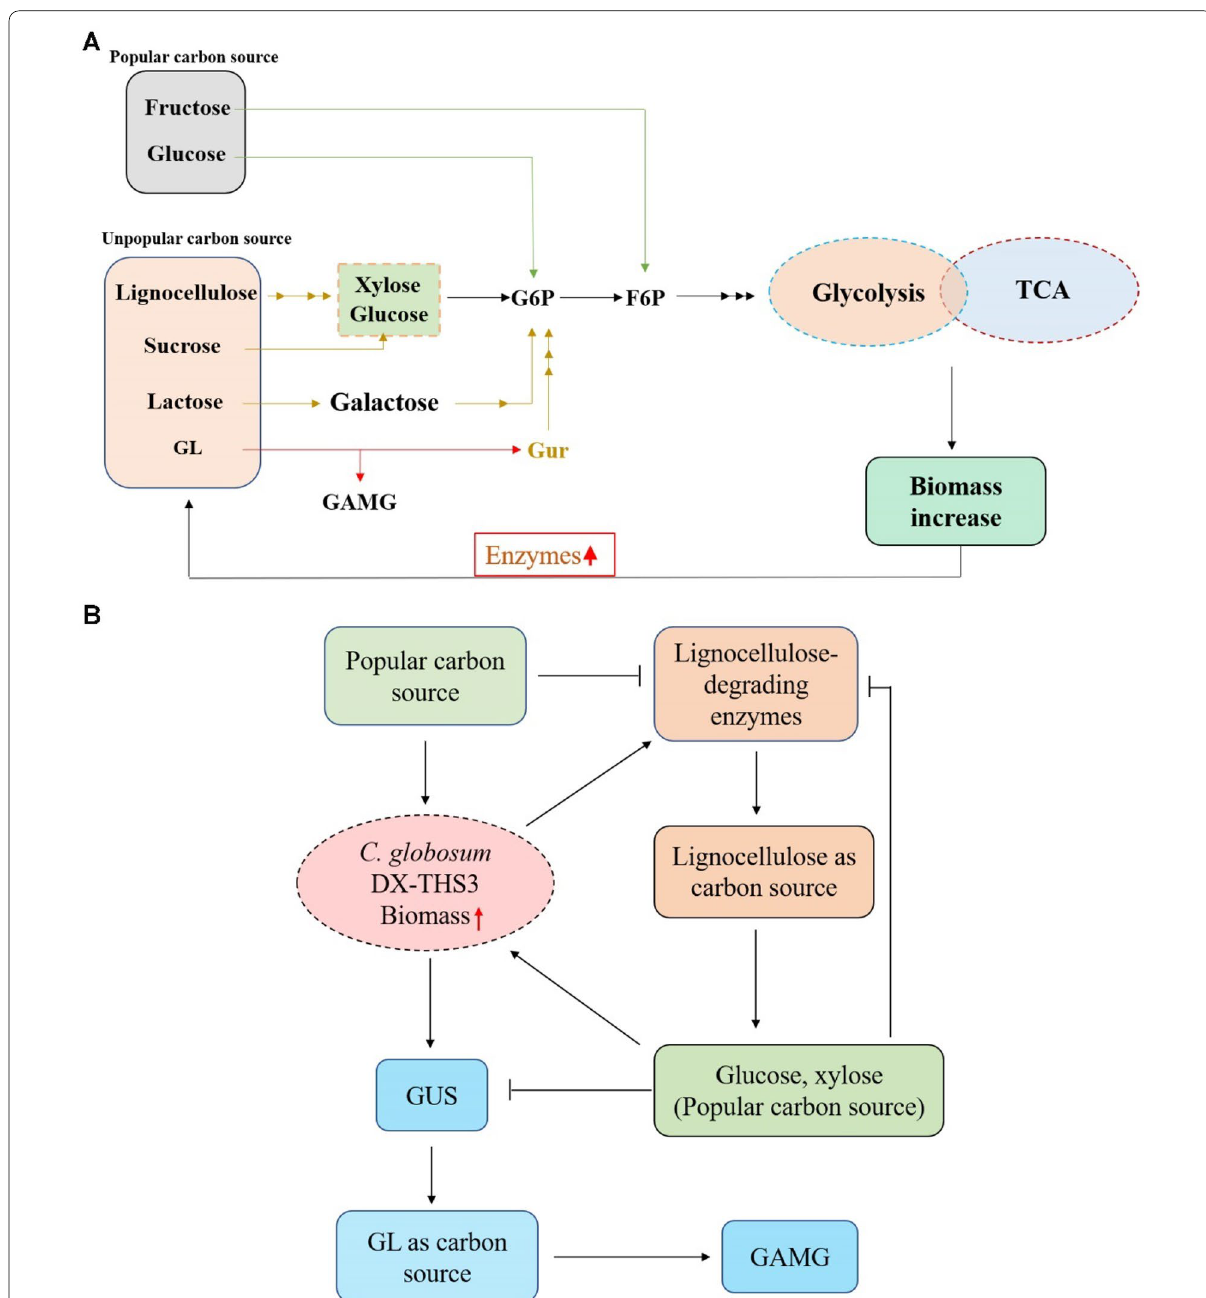
Fig. 5 Predicted mechanism for promoting GAMG production by the addition of fructose to the medium. A Fructose and glucose (popular carbon sources) were more rapidly utilized by C. globosum DX-THS3 than lignocellulose, sucrose, lactose, and GL because such popular carbon sources can directly enter glycolysis and TCA cycle. B Popular carbon sources can promote the rapid accumulation of C. globosum DX-THS3 biomass, producing more lignocellulose-degrading enzymes, rapidly utilizing lignocellulose, and finally fast-transforming GL into